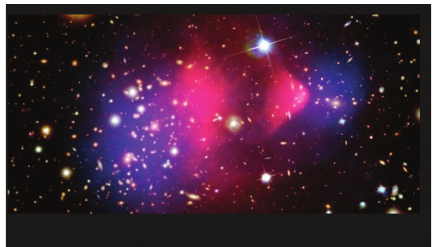
Figure 7: A composite X-ray/optical image of the galaxy cluster 1E 0657-56, also known as the “Bullet Cluster.” This cluster was formed following the collision of two large clusters of galaxies. The X-ray image, pink, is from the Chandra X-Ray Observatory. The optical image is from the Magellan telescope and the Hubble Space Telescope; the galaxies are orange and white. The distribution of mass as determined by gravitational lens analysis is